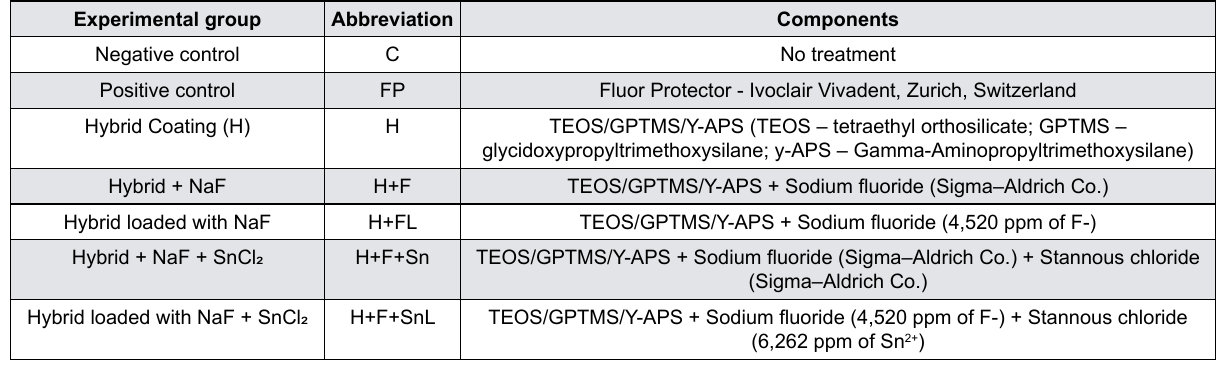
Figure 1- Experimental groups and